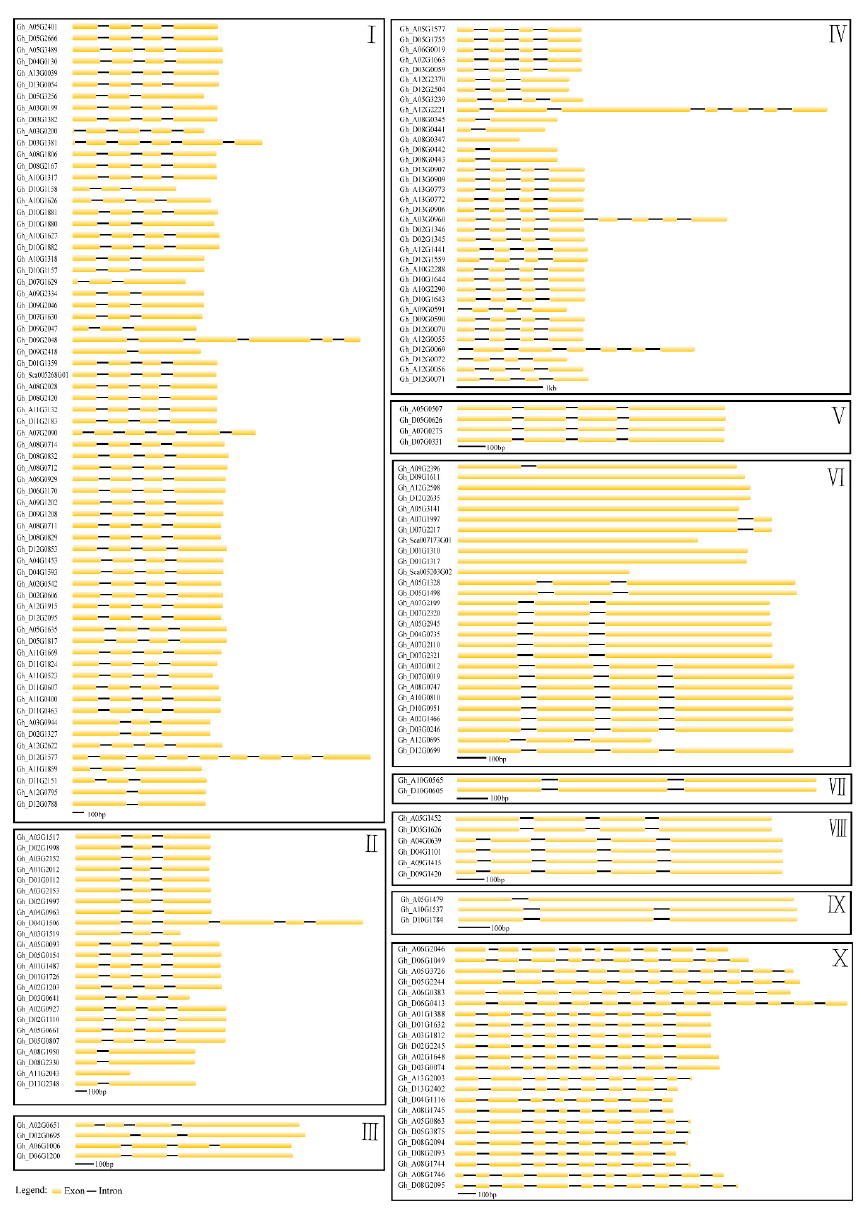
Figure 2. Exon–intron structures of the 198 identified upland cotton POD genes. Exons and introns are indicated by yellow cylinder bars and black lines, respectively. indicated by yellow cylinder bars and black lines,